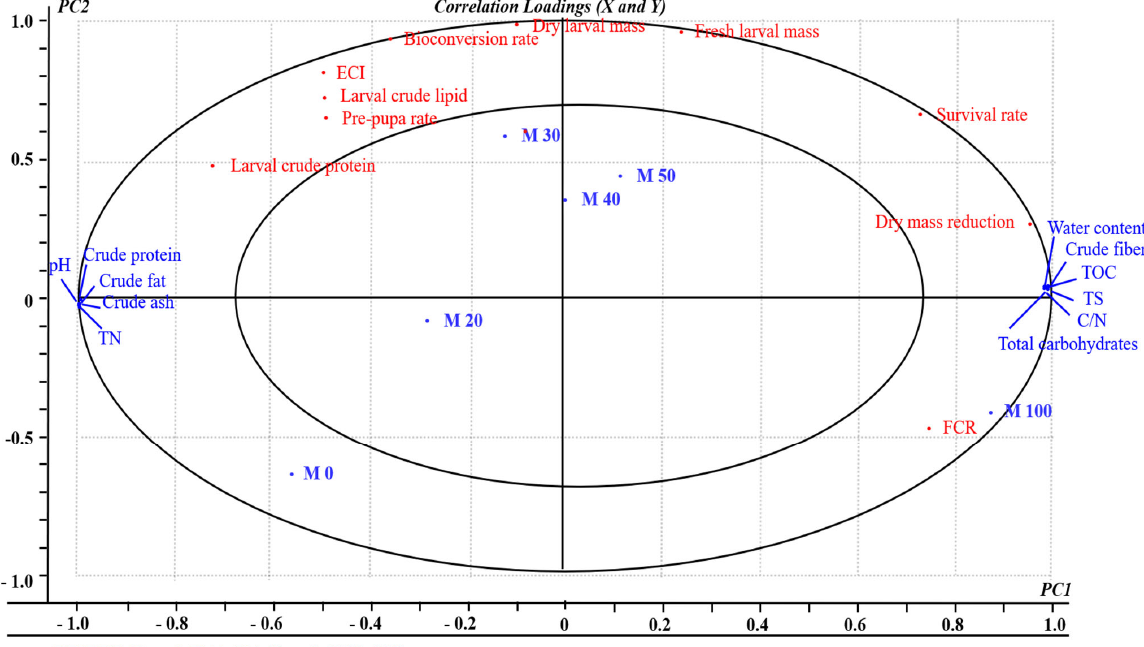
Figure 2. The correlation between the nutritional constituents of mixed organics and growth perfor- mance of BSFL from the PLSR correlation loading plot for samples. Six feed mixtures of SCR:KW were formulated: (0:100) M0, (20:80) M20, (30:70) M30, (40:60) M40, (50:50) M50, (100:0) M100. TOC: total organic carbon; TN: total nitrogen; TS: total sulfur; C/N ratio: carbon/nitrogen; FCR: feed conversion ratio; ECI: conversion efficiency of ingested food.